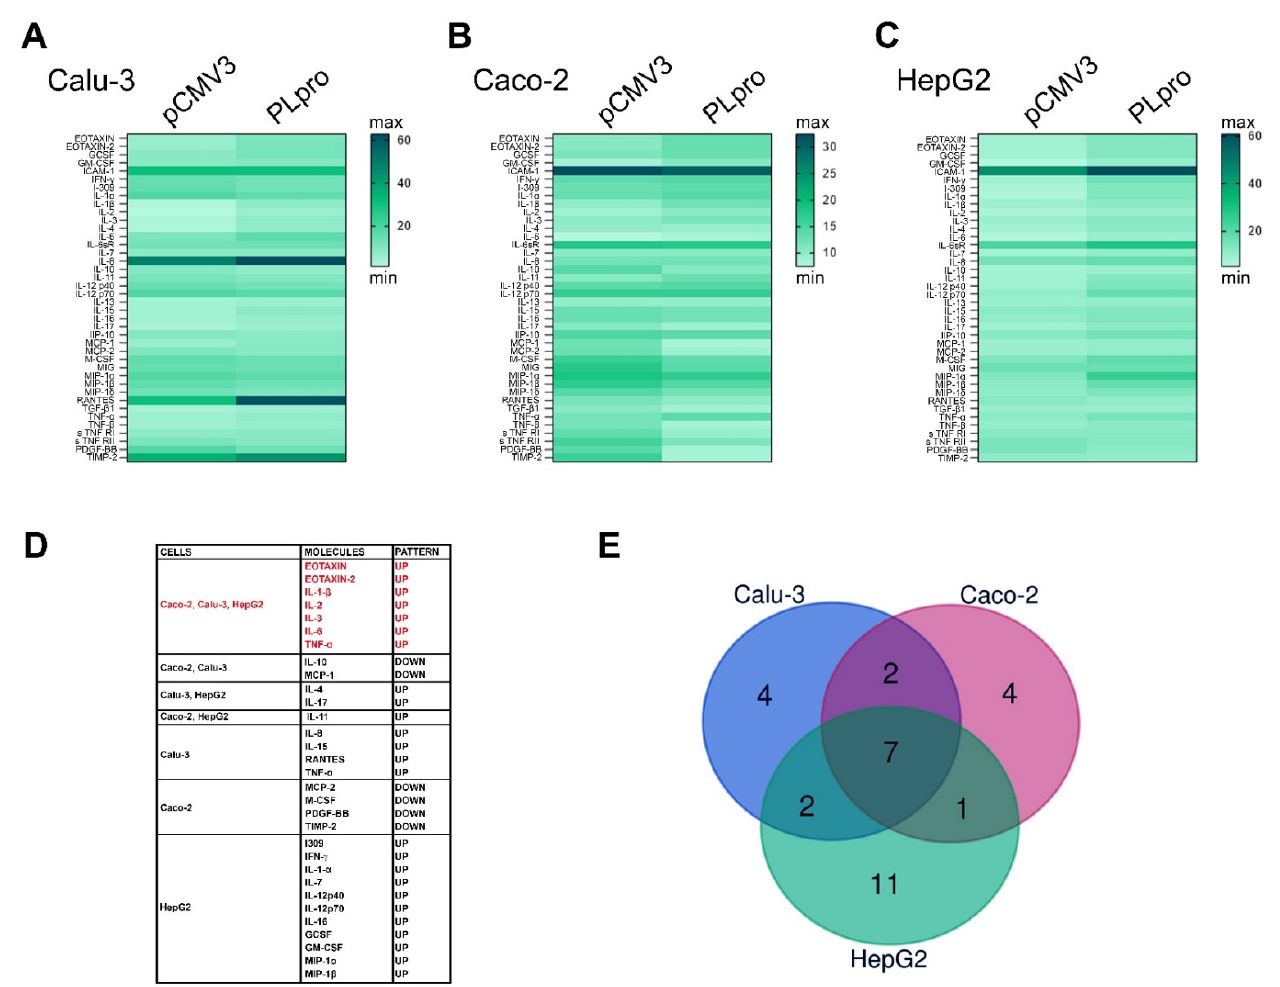
Figure 4. PLpro alters the expression of pro-inflammatory proteins in epithelial cells. Heatmap representation of semi-quantitative expression of 40 pro-inflammatory cytokines and chemokines by antibody array in Calu-3 ( A ), Caco-2 ( B ), and HepG2 cells ( C ) expressing PLpro compared to their pCMV3 counterpart. ( D ) Box reporting the list of significantly up- or down-regulated pro- inflammatory proteins in all cell lines after transfection with PLpro (PLpro) compared to empty vector (pCMV3). ( E ) Venn diagram of commonly altered pro-inflammatory molecules in Calu-3, Caco-2 and HepG2 expressing PLpro. Data are reported as mean of Integrated Density values of two independent experiments repeated at least in duplicate.